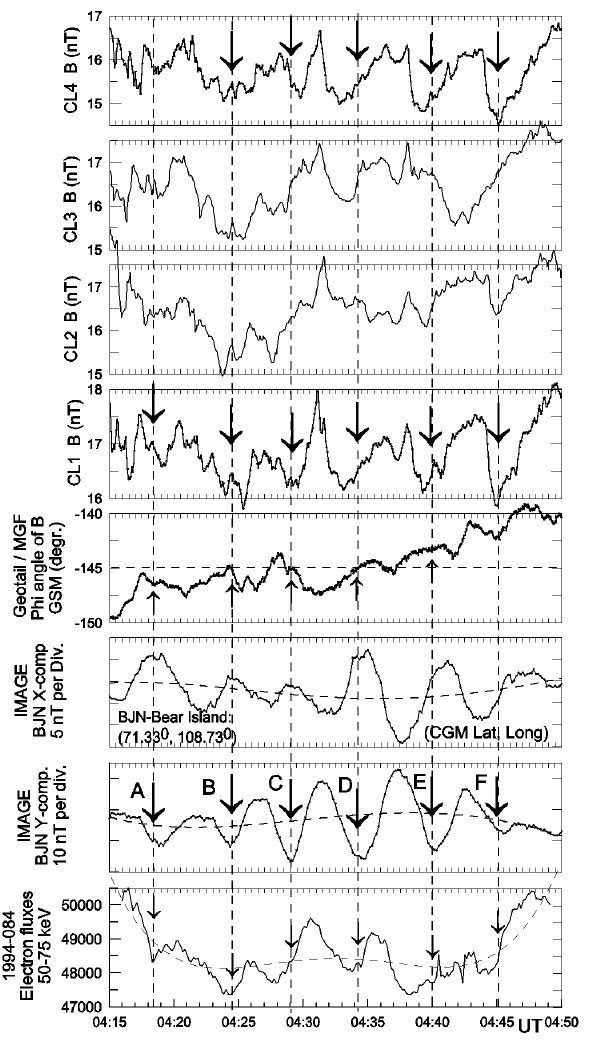
Fig. 5. From top to bottom, magnetic field amplitudes (in nTs) from Cluster 4, 3, 2 and 1, magnetic field azimuthal angle φ (in degrees) from Geotail, X and Y components from the BJN station magne- togram (in nTs), and 50-75keV energetic electron differential fluxes from the 1994-084 satellite. The vertical dashed lines define the distinct decreases marked with the capital letters A-F along the Y component trace of the BJN station.